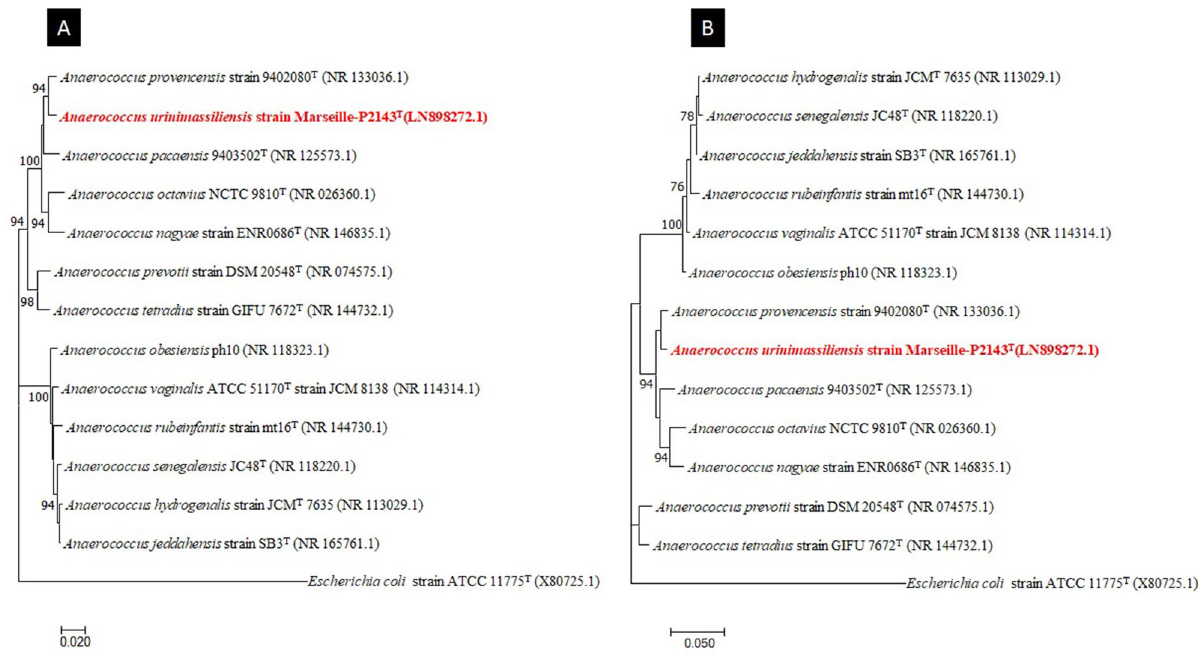
Figure 2. Phylogenetic tree highlighting the position of Anaerococcus urinimassiliensis Marseille-P2143 T sp. nov., with regard to other closely related species. Genbank accession numbers of 16S rRNA are indicated in parentheses. Sequences were aligned using MUSCLE with default parameters, phylogenetic inference were obtained using the neighbor joining ( A ) and Maximum likelihood ( B ) method and the MEGA X software. Bootstrap values obtained by repeating the analysis 50 times to generate a majority consensus tree are indicated at the nodes. The scale bar indicates a 2% and 5% nucleotide sequence